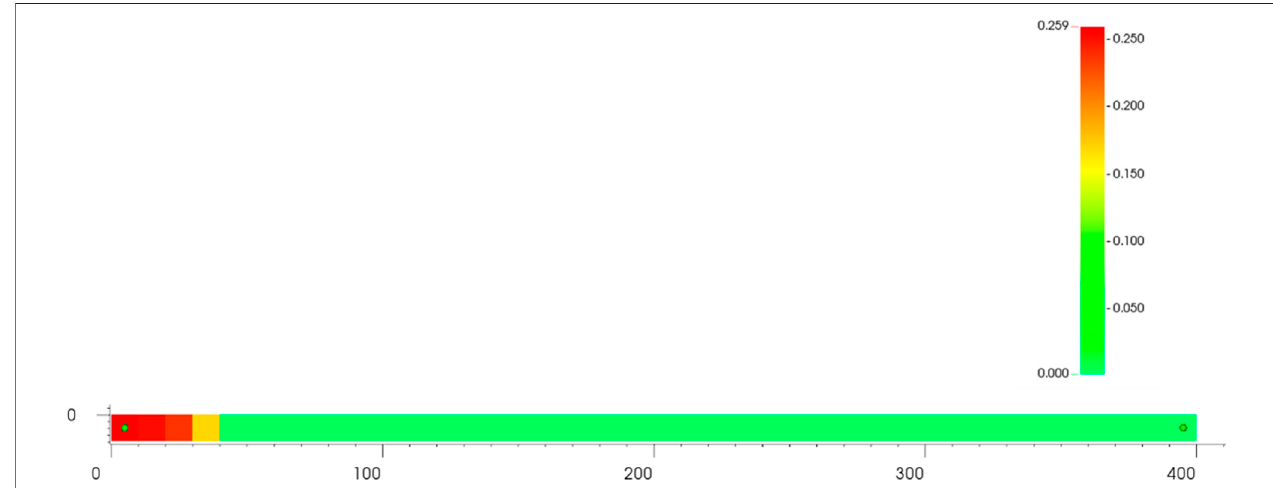
FIGURE 4 | Gas saturation.